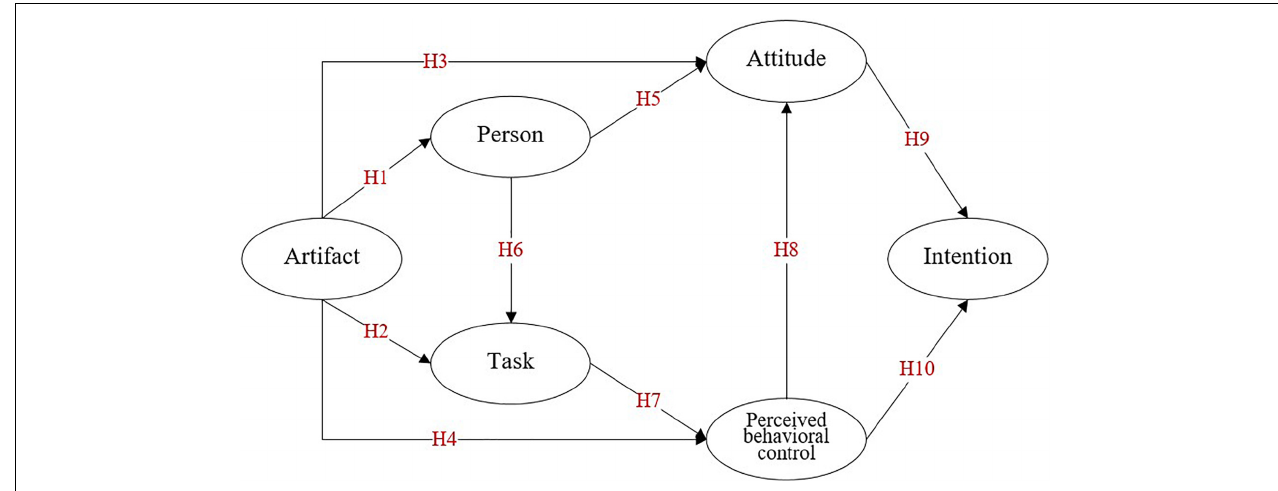
FIGURE 1 | Research